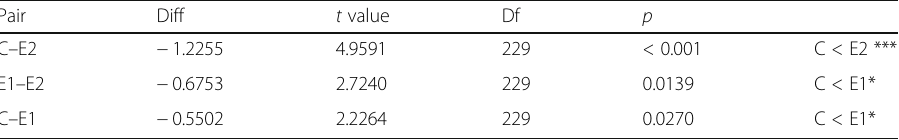
Significant code : “ *** ” .001, “ ** ” .01, “ * ” .05, “ . ” .1, “ ”